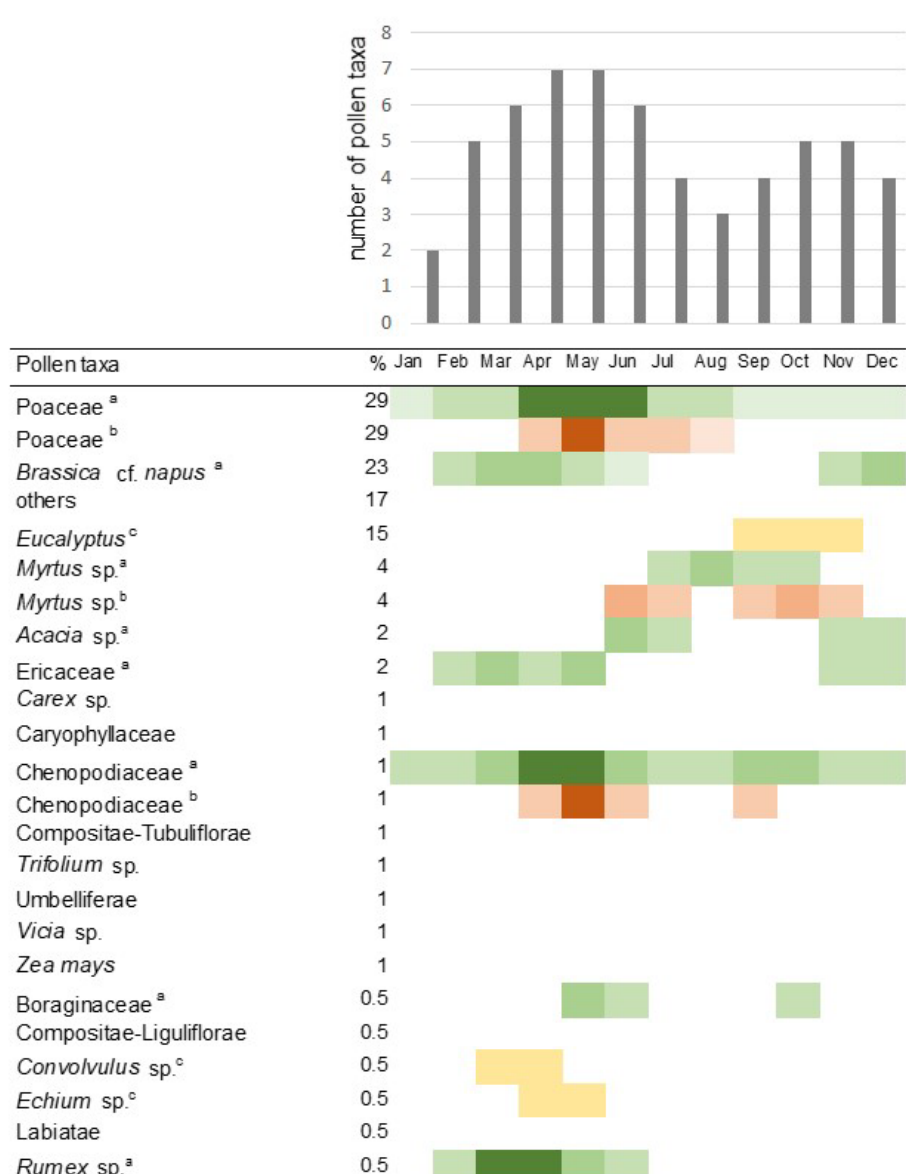
Figure 1. Combined aerobiological and phenological calendar of pollen taxa found in Tunisian honey. a : Flowering time from aerobiological data [8] covering northern Tunisia shown in green; deep green indicates the main pollination period. b : Flowering time from another aerobiological dataset [8] covering Tunisia shown in red. Dark shades mean flowering peaks, according to the original illustrations. c : Flowering time from phenological data [9] shown in yellow. ‘Pollen taxa %’ means the relative abundance of pollen taxa in the Tunisian honey. In [8], taxa are referred to as: Amaranthaceae (instead of Chenopodiaceae), Erica (instead of Ericaceae), Borago (instead of Boraginaceae), Brassicaceae (instead of Brassica cf. napus ), and Myrtaceae (instead of Myrtus ), in [10]: ‘Graminees’ (instead of Poaceae), ‘Myrtacees’ instead of Myrtus ), in [9]: Eucalyptus gomphocephalla (instead of Eucalyptus ). Polygalaceae, found in low numbers (<0.5%) are not shown, as flowering data is not available for this